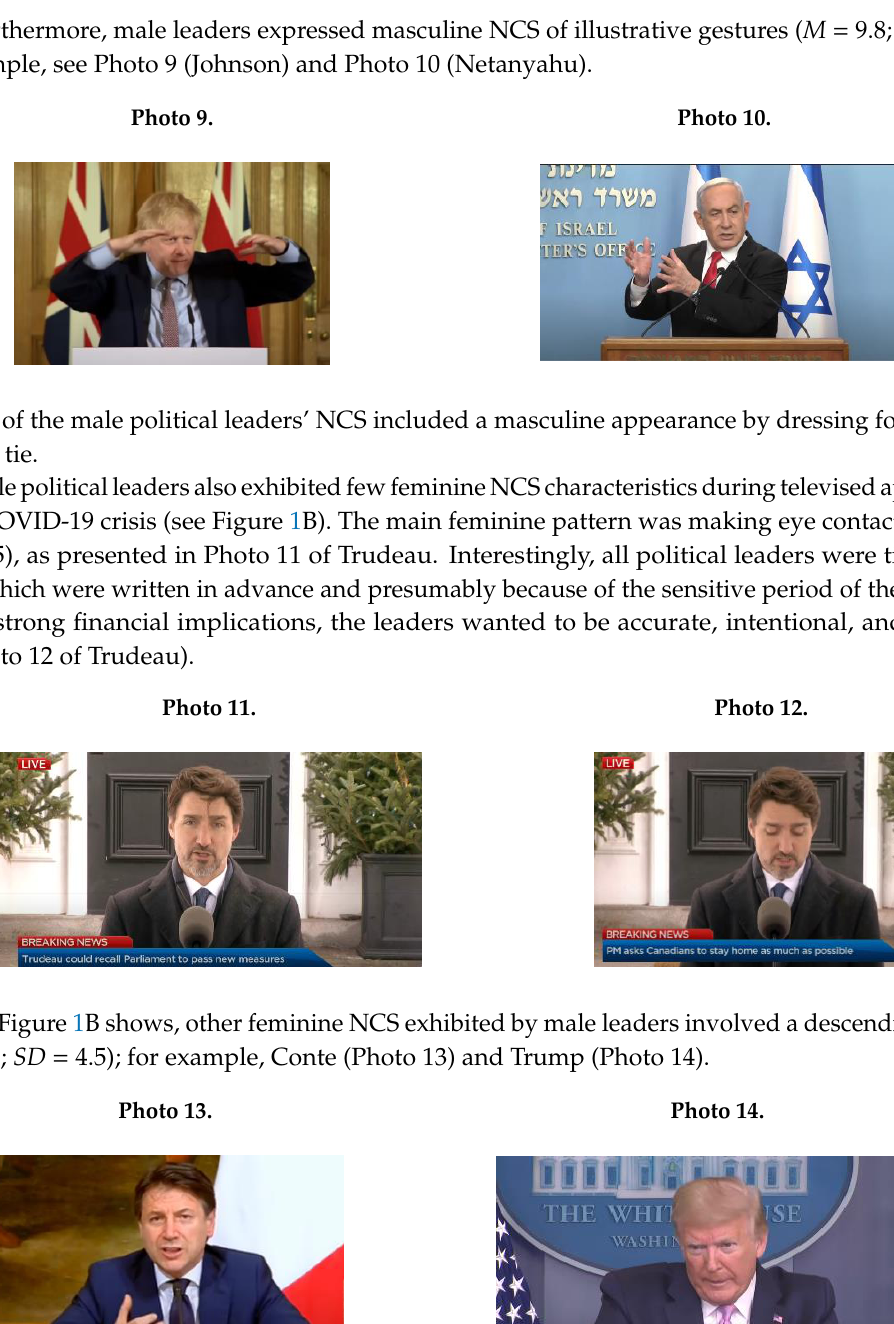
Photo 5. As Figure 1A indicates, male political leaders’ masculine NCS contained sharp movements ( M = 7.2; SD = 4.21) and anger (see Photo 6 of Trump using a sharp beating gesture). Furthermore, male leaders’ behavior contained masculine assertive gestures of warning and threatening ( M = 8.4; SD = 2.07). In Photo 7, for example, Trump used a finger-pointing gesture of warning and threat, combined with an angry and threatening facial expression. Photo